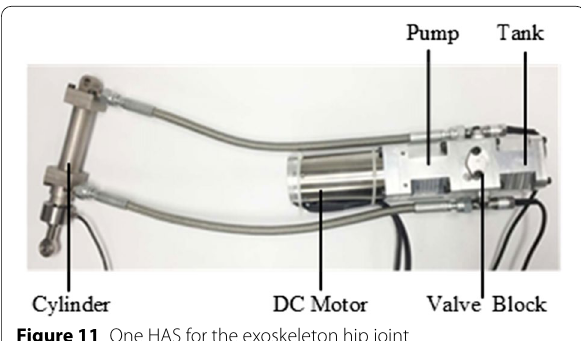
Figure 11 One HAS for the exoskeleton hip joint